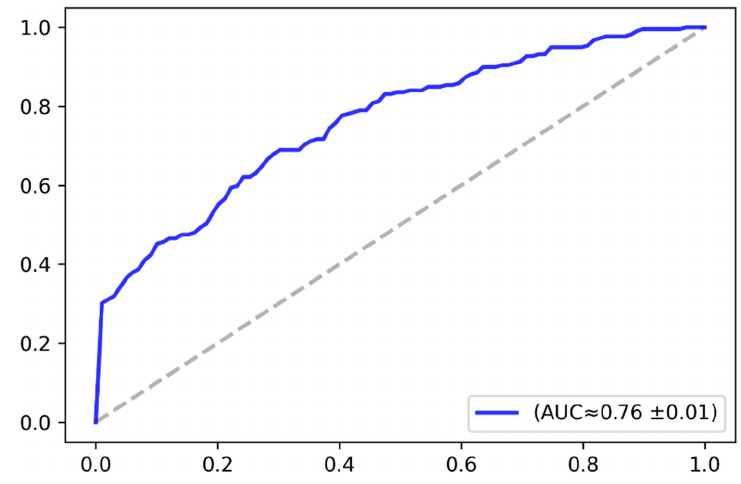
Figure 10. ROC curve after applying VAE-based data augmentation. Table 2. Model performance after data